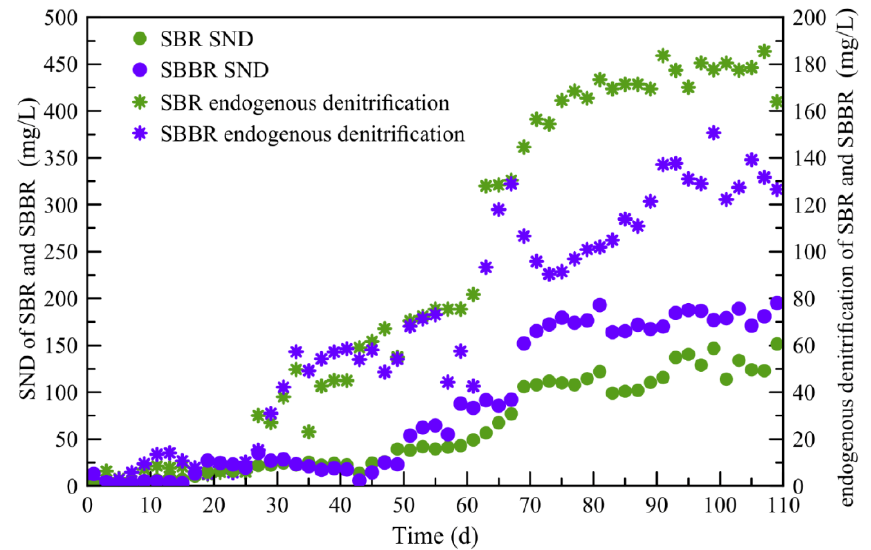
Figure 4. Comparison of nitrogen removal methods between SBR and SBBR.